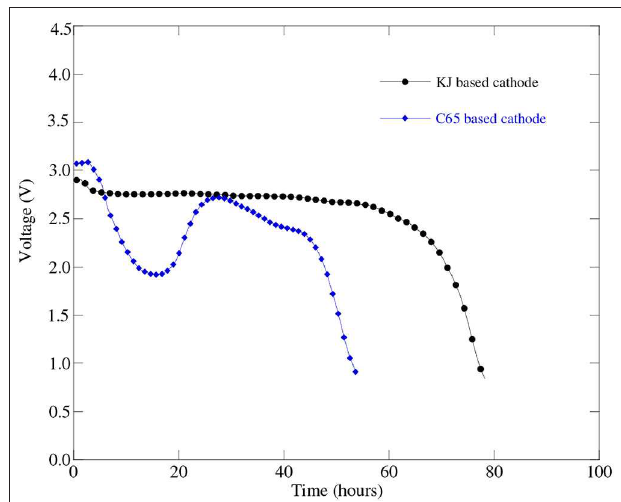
FIGURE 4 | Discharge profiles of Li-air battery cell (Cell#51C in Table 3 ) at 0.1mA (i.e., 50 mA/g) discharge current with a KJ based cathode and the Li-air battery cell (Cell#59C in Table 3 ) with a C65 based cathode having the same level of carbon loading.